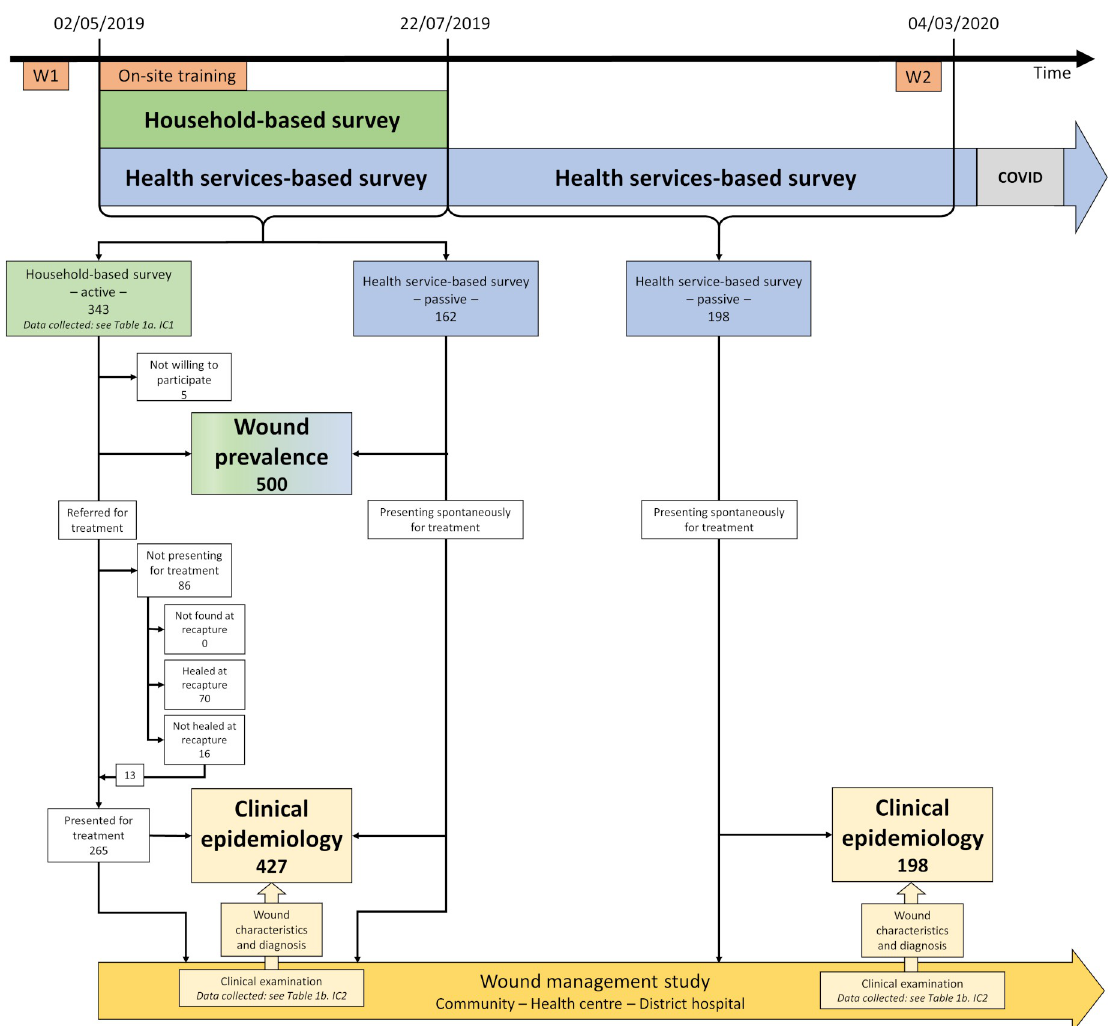
Fig 4. Enrolment of wound events during household- (active case finding) and health services-based survey (passive case finding). Wound event was defined as an injury (mechanical trauma, burn, etc) or a specific pathology (BU, yaws, etc) leading to one or multiple wounds. Wounds enrolled on the same date and attributed to the same aetiology were considered due to the same wound event. Specific aetiologies, such as BU or yaws, that could lead to multiple wounds over time were considered as a single wound event.